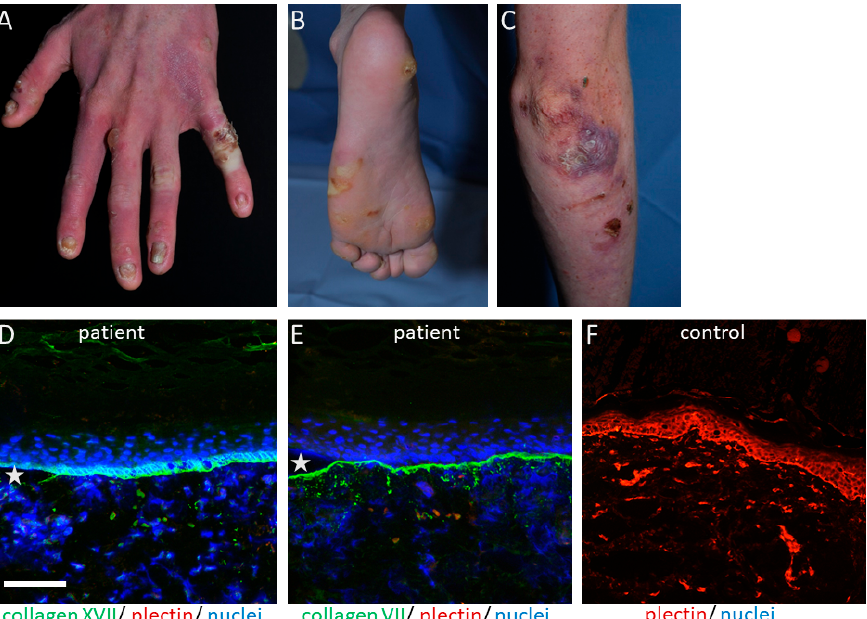
Figure 1. Cutaneous manifestations and IF findings in a 20-year-old patient with EBS-MS: Firm blisters and erosions on hands ( A ), feet ( B ), and elbow ( C ), together with crusts, are found on the skin of a patient with strongly reduced plectin expression. Hypopigmented patches, as well as erythematous macules, developed after healing of the blisters, as well as focal palmoplantar keratoderma, mostly on the mechanically stressed areas, causing great discomfort to the patient. ( D ) Collagen XVII (green, ( D )) was stained on both the blister roof and floor, while ( E ) collagen VII only stained on the floor of the patient’s skin (20 × magnification), thus providing a “pseudojunctional EBS” immunofluorescence pattern. Plectin (red in ( D , E )) is almost completely absent, compared to the control skin ( F ). The nuclei are visualized with DAPI, with asterisks highlighting the